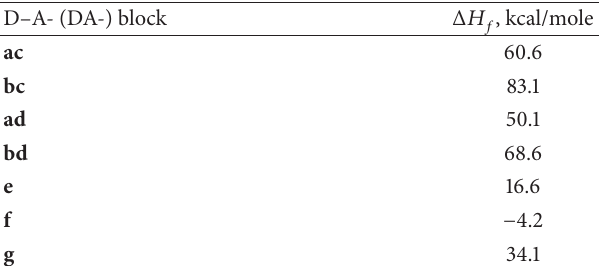
Table 3: Enthalpies of formation for D–A- (DA-) blocks. D–A- (DA-)